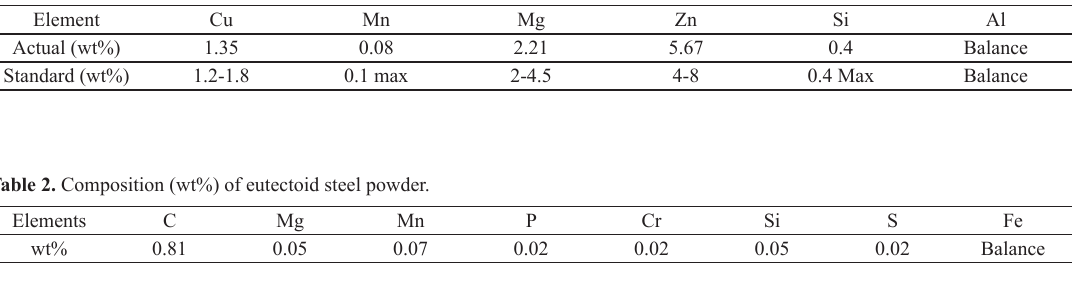
Table 1. Composition (wt%) of Al 7075 alloy.